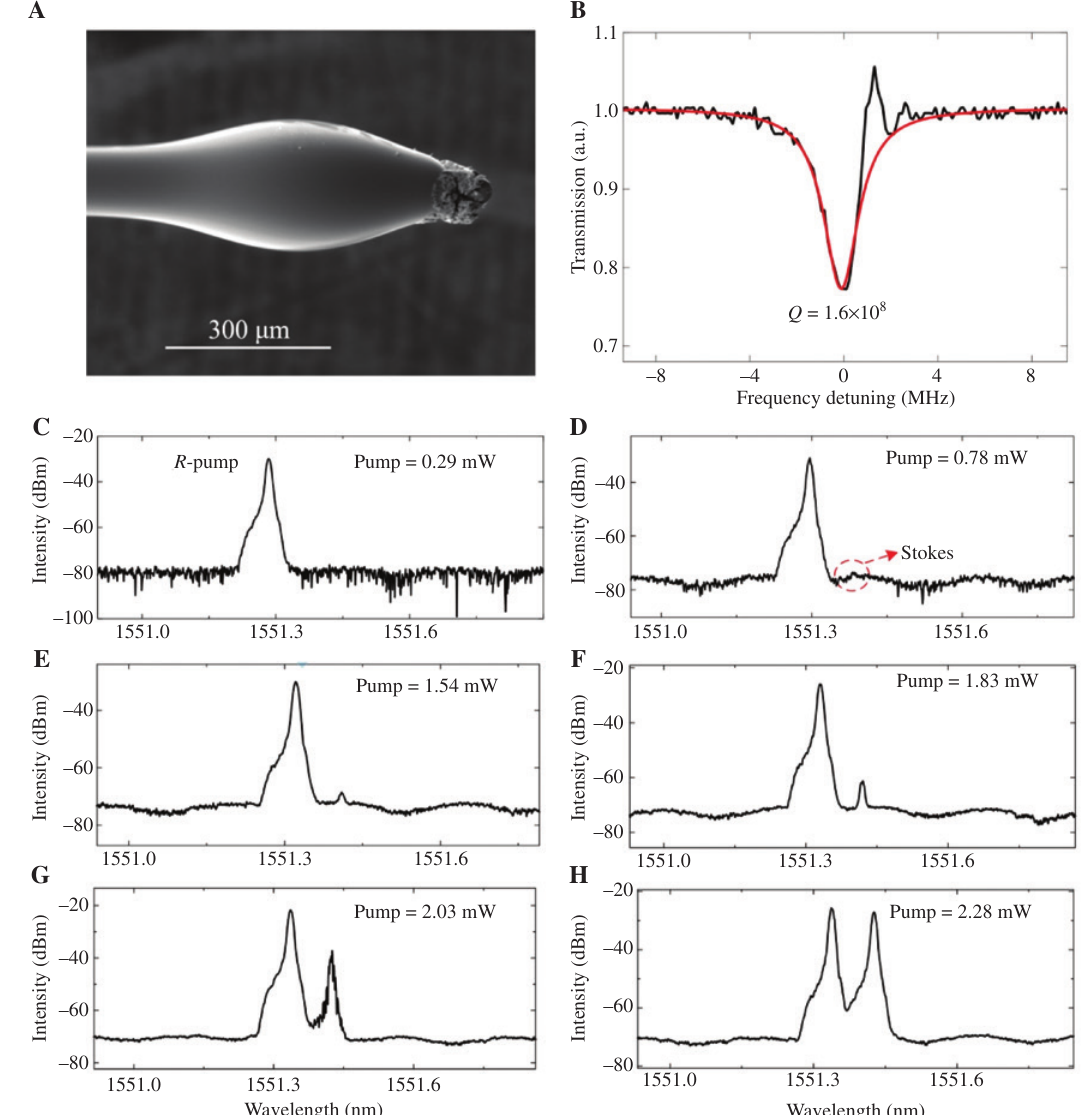
Figure 6: Device performance of the hybrid microbottle resonator with an equatorial diameter of about 237 μ m. (A) SEM image of the hybrid microbottle resonator. (B) Measured transmission spectrum of a specific mode. The red line is Lorenz fitting. (C–H) Brillouin lasing spectra for different pump